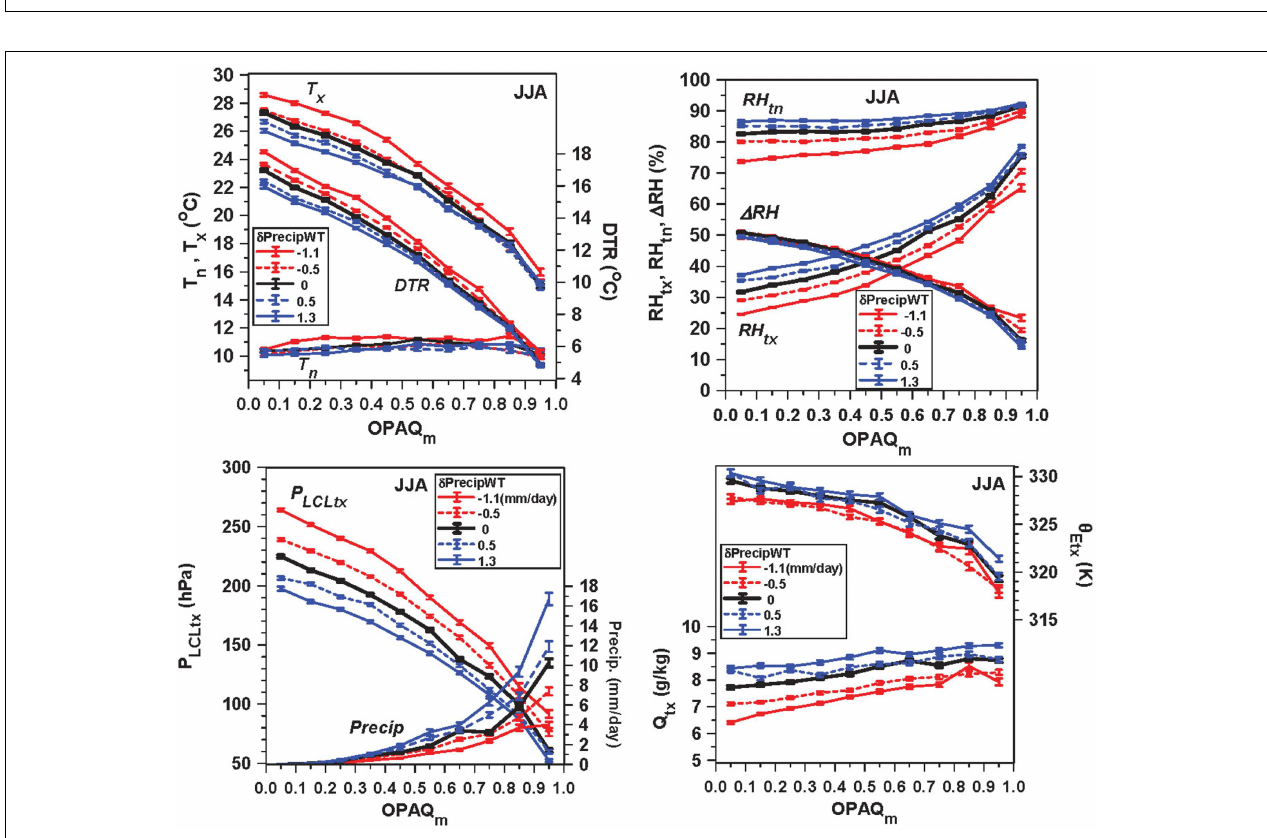
FIGURE 12 | Stratification of daily climate by opaque cloud and δ